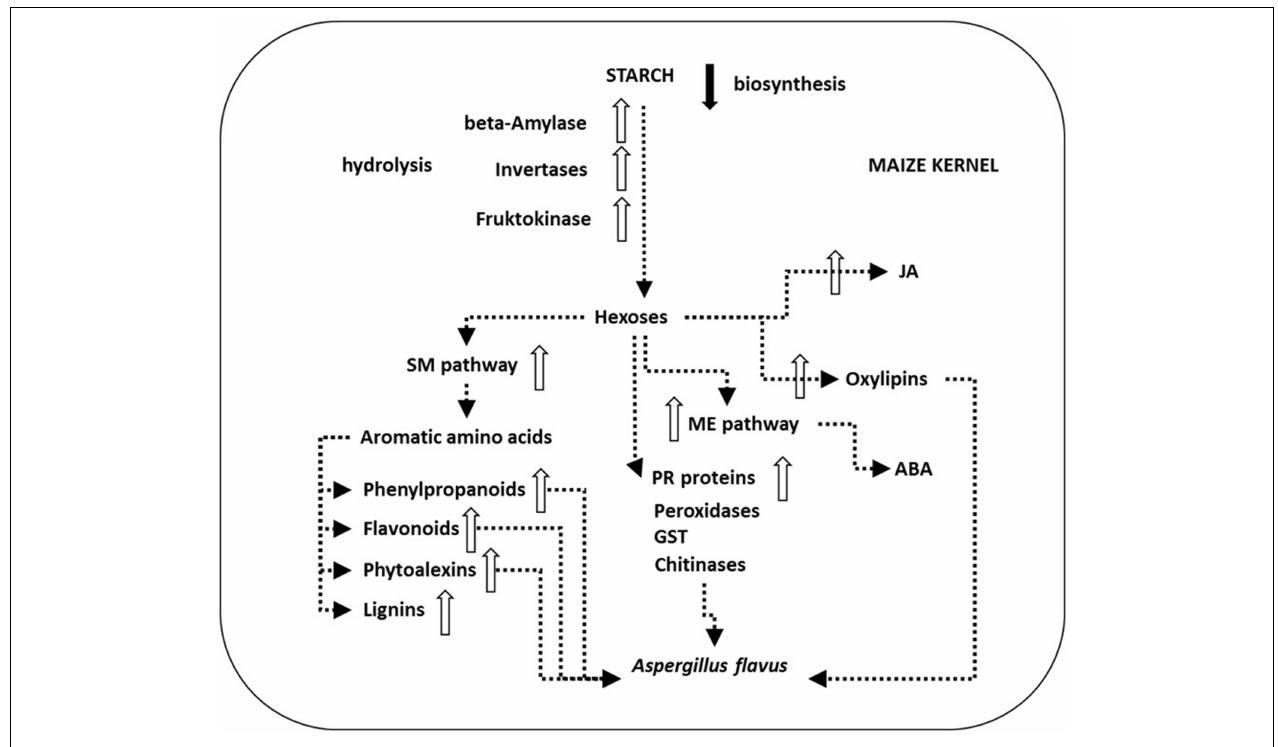
produced hexoses flow through the up-regulated shikimate (SM) pathway, the methylerithryole (ME) pathway and toward up-regulated jasmonic acid (JA) and oxylipin biosynthesis, and feed pathogenesis related (PR) protein synthesis, e.g., peroxidases, glutathione S-transferase (GST) or chitinases that were also found up-regulated during infection. Oxylipins up-regulate aflatoxin (AF) biosynthesis and sexual reproduction in A. flavus and down-regulate fungal growth. Up-regulation of the SM pathway leads to the production of antifungal compounds flavonoids, phenylpropanoids, phytoalexins, and up-regulated lignin production in maize. Up-regulated plant hormone JA and abscisic acid (ABA) production is crucial in these defense mechanisms ( Dolezal et al.,